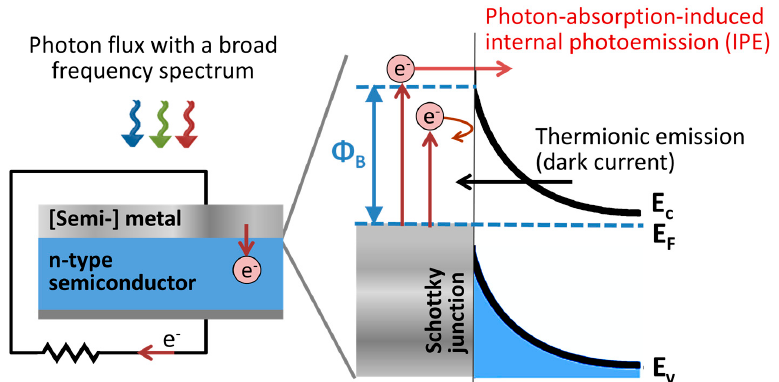
Figure 1. Schematic of the photon-to-electrical-current energy conversion platform combining either a metal or a semimetal photon absorber and the Schottky barrier as the hot-carrier filter. Hot electron internal photoemission process across the Schottky junction between a (semi-)metal and an n-type semiconductor is also schematically illustrated.